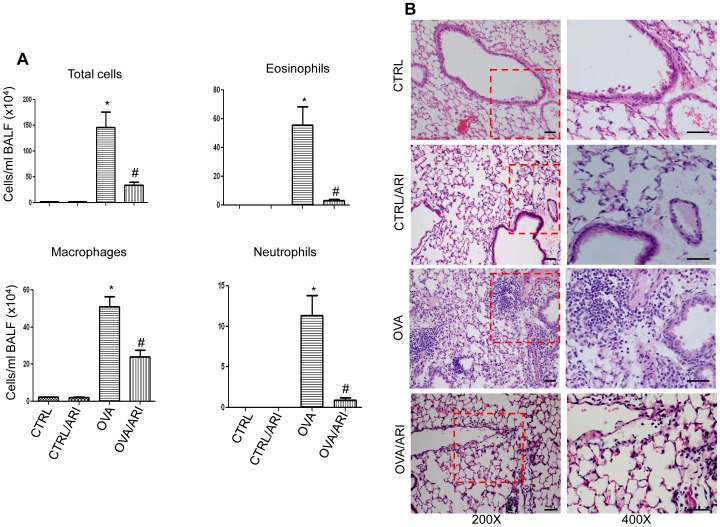
AR inhibition blocks leukocytes accumulation in BAL fluid and infiltration in the lungs of OVA–challenged chronic asthmatic mice.(A) The total as well as differential cell counts were performed in BAL fluids collected 48 h after final OVA-challenge. The total cells, eosinophils, neutrophils and macrophages per ml BAL fluid is given as mean ± SD (n = 6 per group), *p<0.01 vs control; #
p<0.05 OVA group (B) Fixed lungs from the different experimental groups were sectioned and stained with hematoxylin and eosin, examined under the light microscope and photomicrographs were taken. A representative image from each group is shown (n = 6), Magnifications 200× and 400×. CTRL, control, ARI, aldose reductase inhibitor, OVA, ovalbumin.